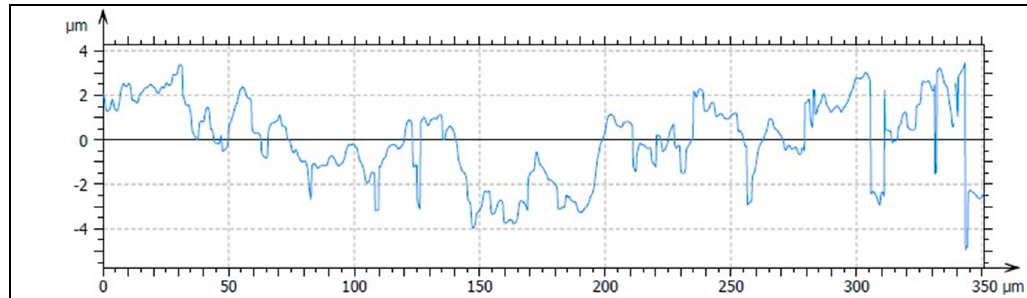
+ AW surface Figure 14. HA + AW surface profilometry. Figure 14. HA Figure 14. HA + AW surface profilometry. Figure 14. HA + AW surface profilometry.